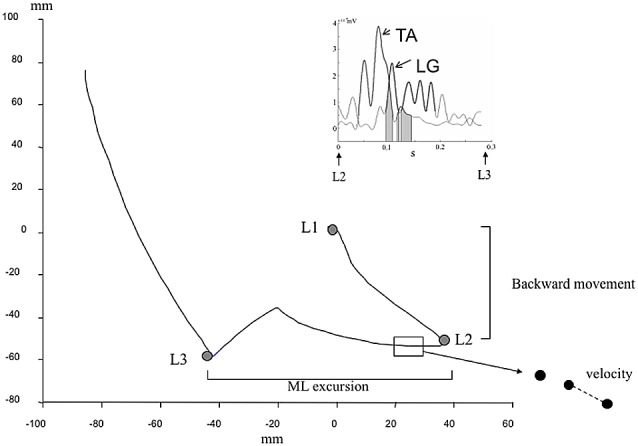
Kinetic and electromyographic (EMG) data used to describe gait initiation. Center of pressure (COP) displacement during gait initiation. L1 represents the position of the COP in normal quiet standing. L2 represents the backward of COP. L3 represents the COP displacement toward the stance limb (STL). Parameters used were the backward COP position during the phase 1 (L1–L2), the medio-lateral (ML) excursion, the velocity (path reported to phase duration). Insert represents tibialis anterior (TA) and lateral gastrocnemius (LG) vs. time during the weight bearing transfer from swing limb (SWL) to STL (From L2 to L3). The bold lines represent when muscle are activated (>25 ms consecutive above the threshold corresponding to the mean ± 3 standard deviation). Gray area represents the phase of coactivation of LG and TA muscles.